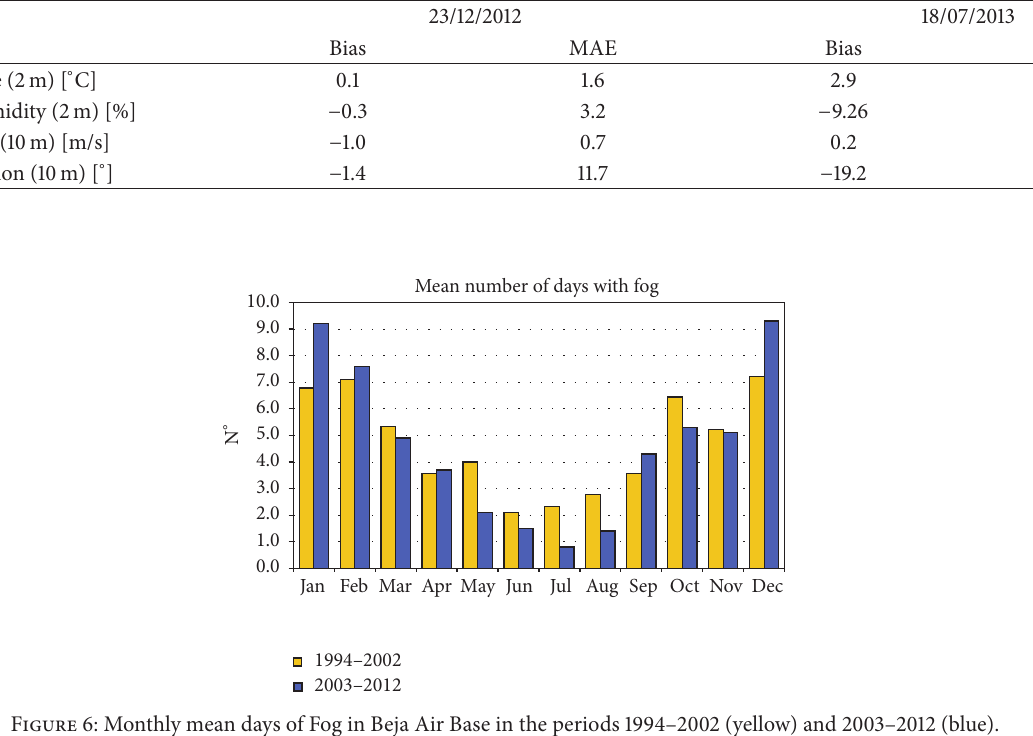
Figure 6: Monthly mean days of Fog in Beja Air Base in the periods 1994–2002 (yellow) and 2003–2012